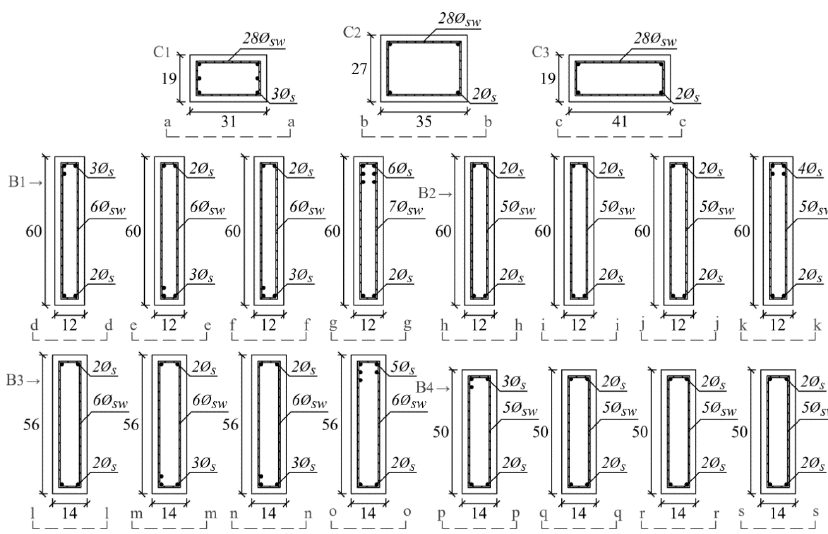
Figure 13. Detailing the optimal sections (dimensions in cm) - Example II: case II.